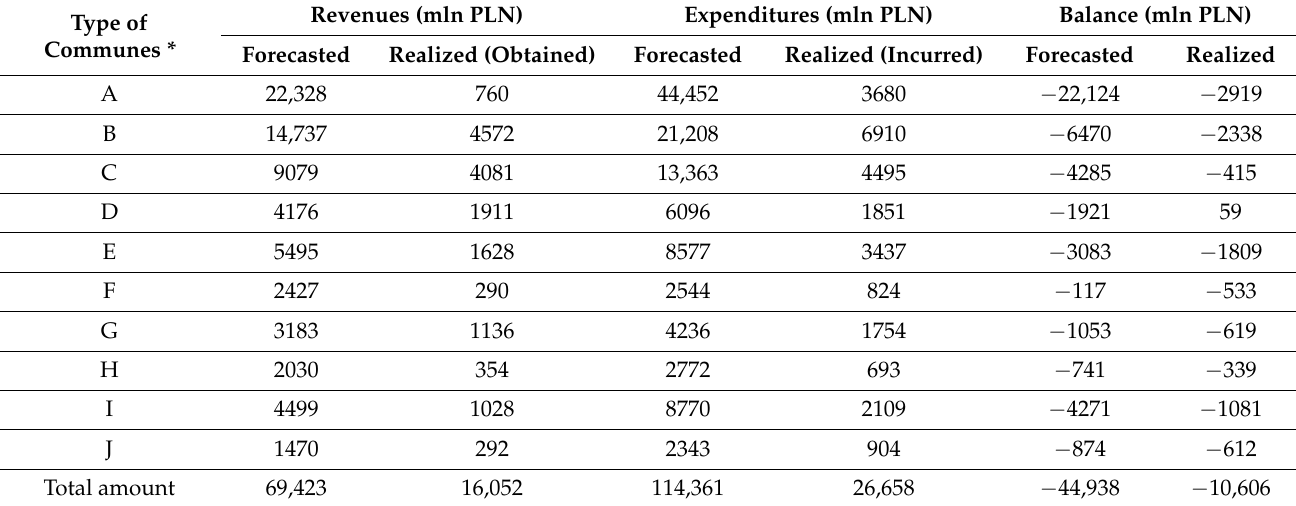
* abbreviations of types of communes explained in Table 1. Source: based on unpublished data of the Ministry of Development and Statistical Office of Poland.